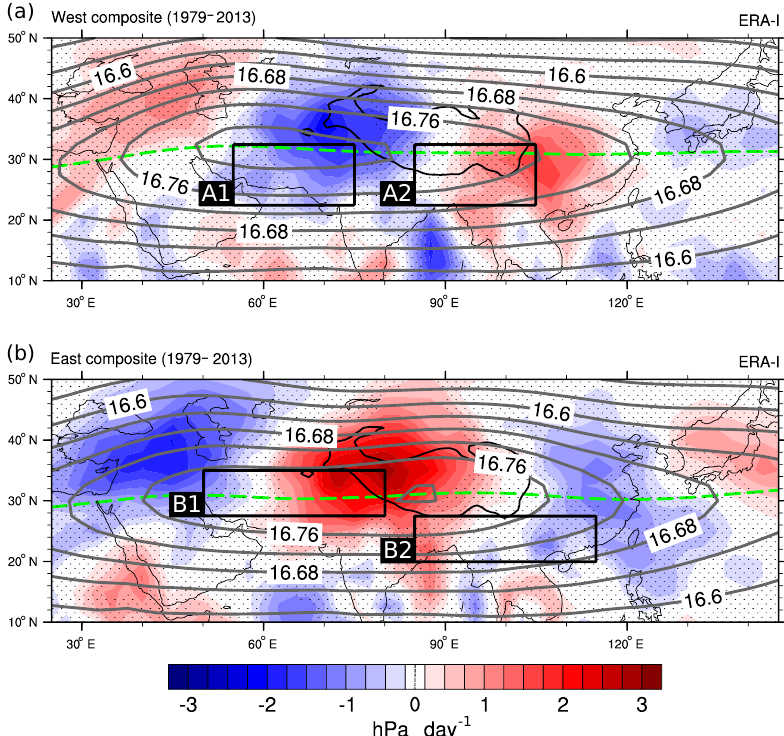
Figure 14. Colour shading displays the mean anomaly of the vertical velocity (hPaday − 1 ) at 100hPa from ERA-I during (a) west and (b) east summers with respect to the JJA mean during 1979–2013. Stippling indicates where the anomalies are insignificant (significance less than 10%). Grey contours show composites of ERA-I geopotential height at 100hPa (in km) during (a) western and (b) eastern summers. The green lines indicate the ridgelines. Black contour shows orography greater than 3km. Black boxes show the averaging regions of geopotential, needed to calculate the SAHI 14 and the SAHI 15 . The SAHI 14 and SAHI 15 are defined as the standardised differences of average geopotential in box A2 (22.5–32.5 ◦ N, 85–105 ◦ E) minus A1 (22.5–32.5 ◦ N, 55–75 ◦ E) and in box B2 (20–27.5 ◦ N, 85–115 ◦ E) minus B1 (27.5–35 ◦ N, 50–80 ◦ E)